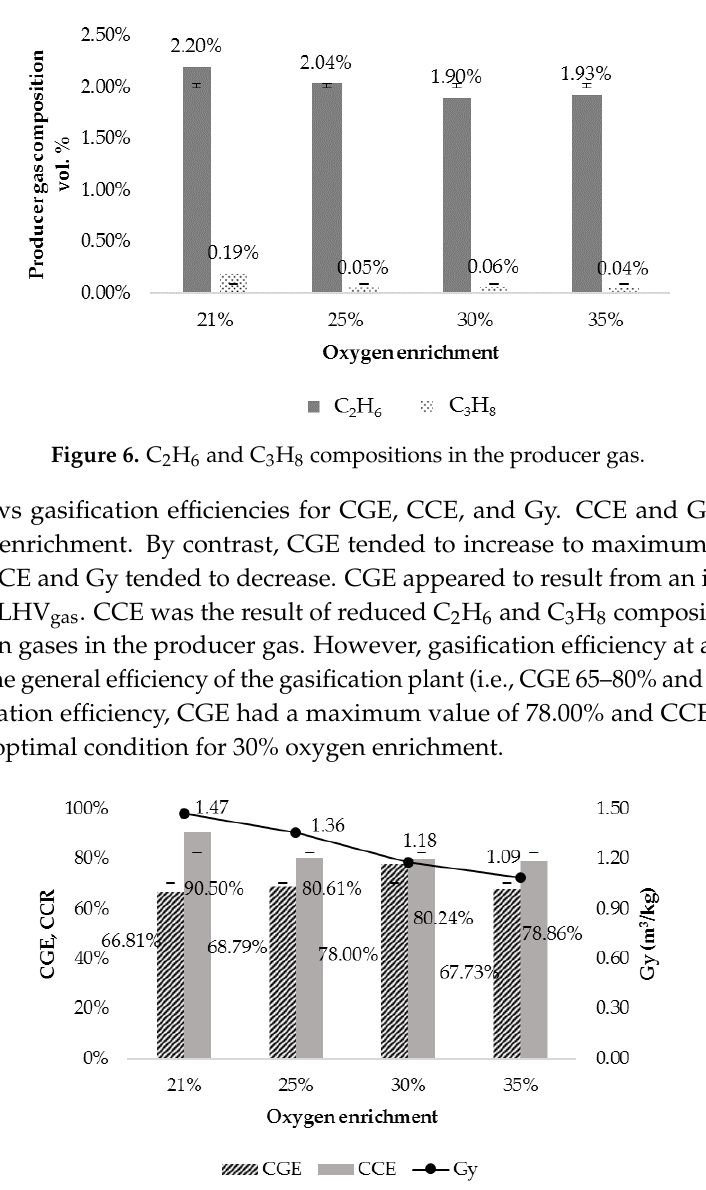
Figure 7. Gasification efficiency trends.